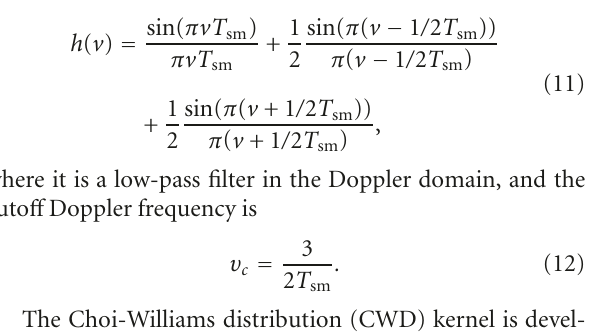
Figure 1: Bilinear product of the voltage variation signal. The autoterms are highlighted in green, while the cross-terms are densely